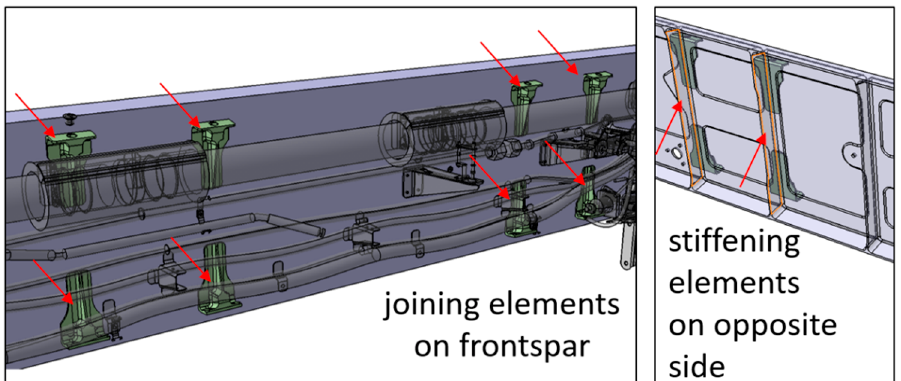
Figure 30. Joining elements for MLE attached to the front spar ( left ) and supporting stiffening elements on opposite side ( right ).